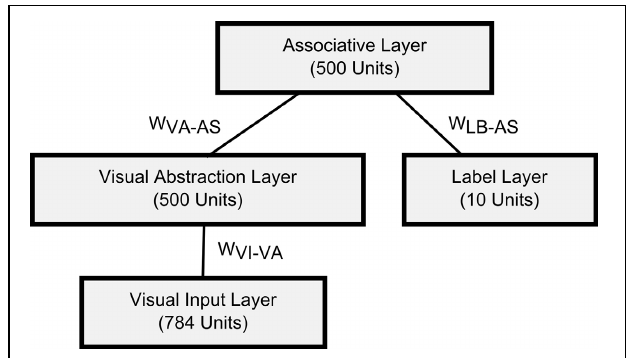
FIGURE 2 | Architecture of the DBN for handwritten digit recognition. The connections between layers represent the weights of a